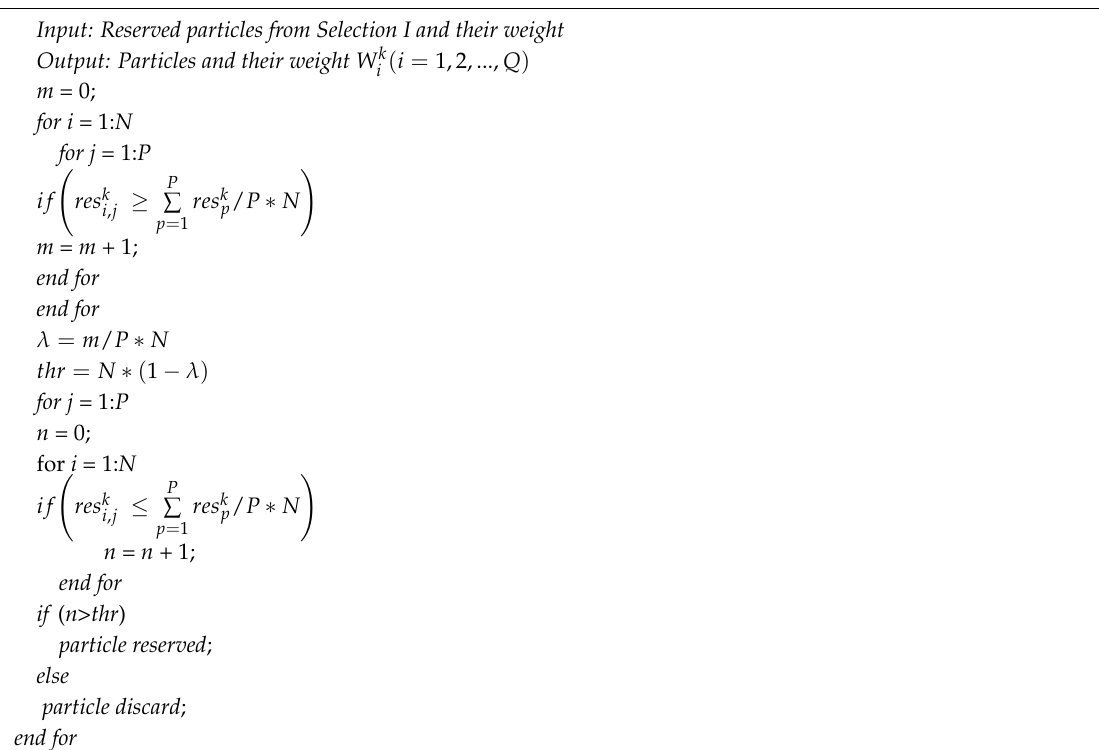
Algorithm 3. Local